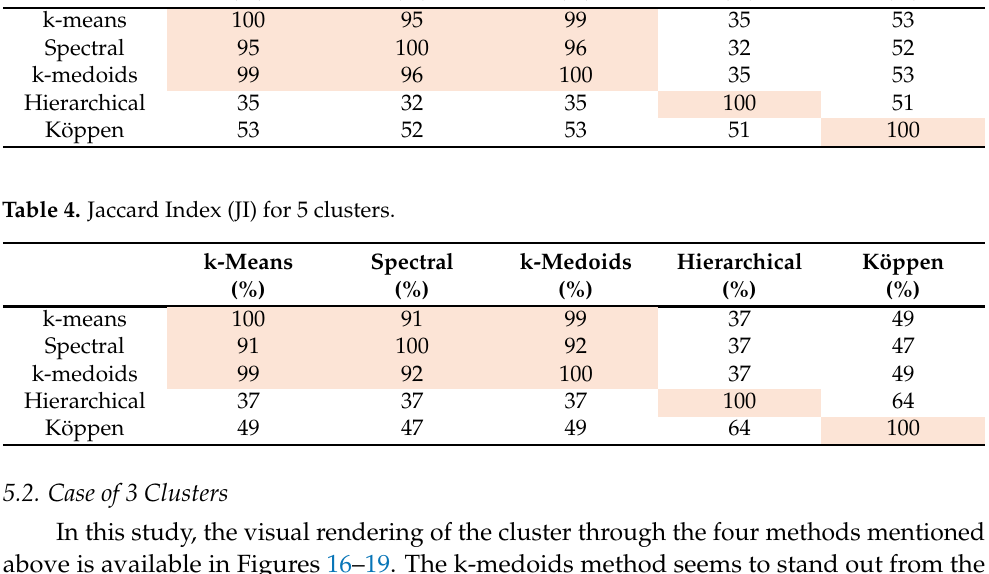
Table 4. Jaccard Index (JI) for 5 clusters.